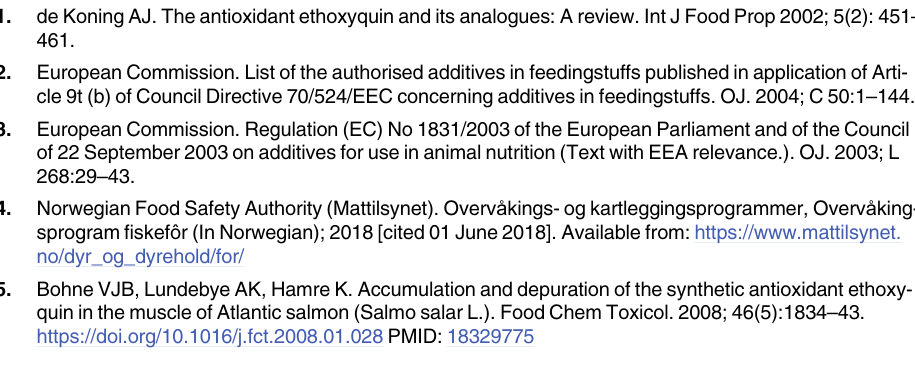
S16 Table. Summary of lower and upper bound benchmark dose 90% confidence intervals (BMDLs and BMDUs, respectively), and models of critical endpoints used in the evalua- tion for a critical